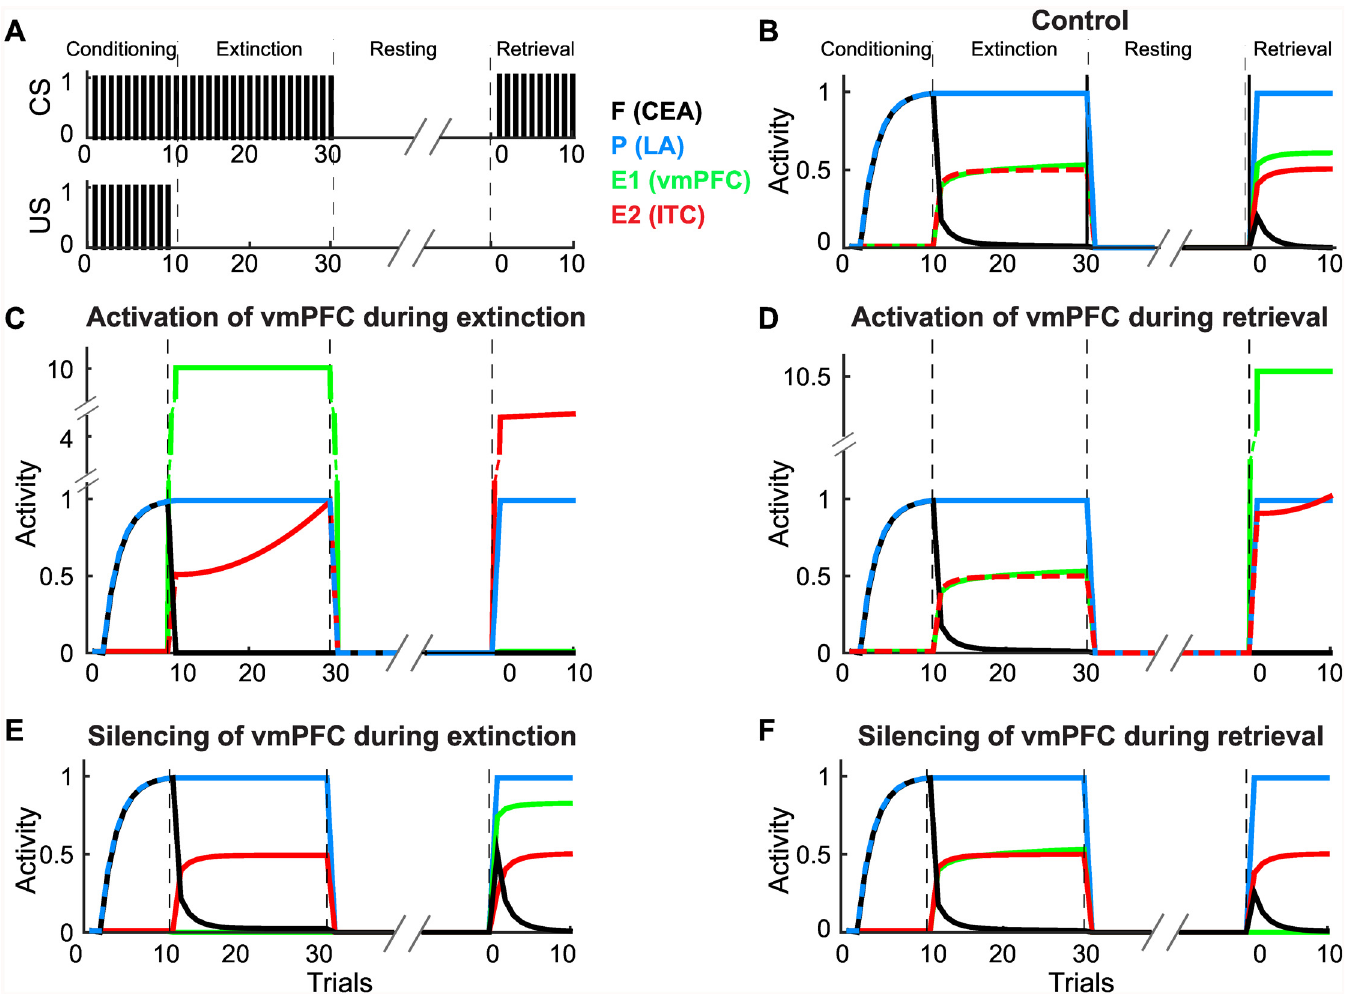
Fig 3. Fear memory in the extended model when the vmPFC was activated and silenced. (A) Schedules of CS and US; the presentation schedules for the CS and US during fear conditioning and extinction were the same as those used in the basic model (Fig 2A), but the resting phase, during which neither the CS nor the US was presented, and the retrieval phase, during which only the CS was presented to evaluate extinction memory, were set after extinction. (B-F) Extended model simulation results for the control condition (B) , vmPFC activation during extinction (C) , vmPFC activation during retrieval (D) , vmPFC silencing during extinction (E) and vmPFC silencing during retrieval (F) . The blue, green, red and black lines indicate the activity of the LA (persistent neurons), vmPFC (extinction neurons), ITC (another group of extinction neurons) and CEA (fear neurons), respectively. Note that overlapping lines were changed to dashed lines to make them